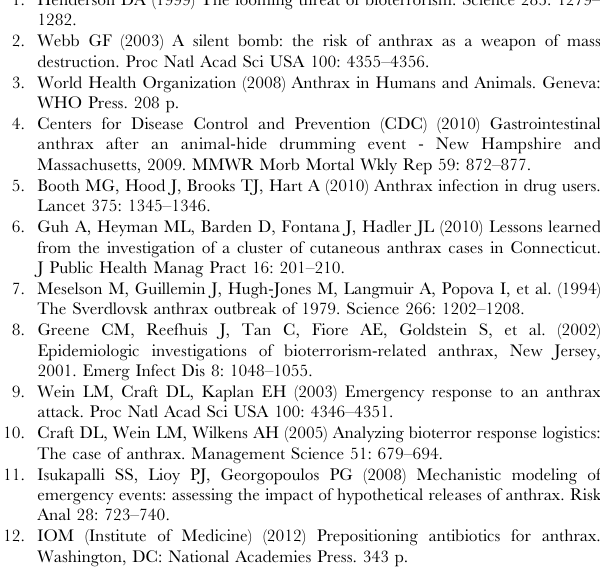
Figure 3 therein. a We consider data from the day of sacrifice to be number of animals infected by that day. Table S5 Cumulative data from Brachman et al. [ 24 ] . Haas [18] fit the exponential dose-response model without a time component to the Brachman data, using an averaging technique [28] that is equivalent to applying the total cumulative dose over each Brachman experimental run as a single data point, as if that cumulative dose was a one-time exposure. The actual total cumulative doses from Brachman runs 3 and 4 as reported were lower that what was applied by Haas. The error was caused by multiplying the reported average daily exposure by the number of days between the first and last exposures, rather than the number of days on which exposure actually